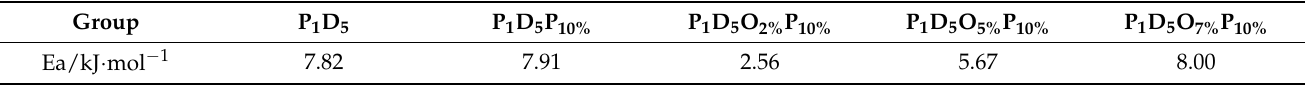
Table 3. Activation energy of membranes prepared with different OVAPOSS doping levels.